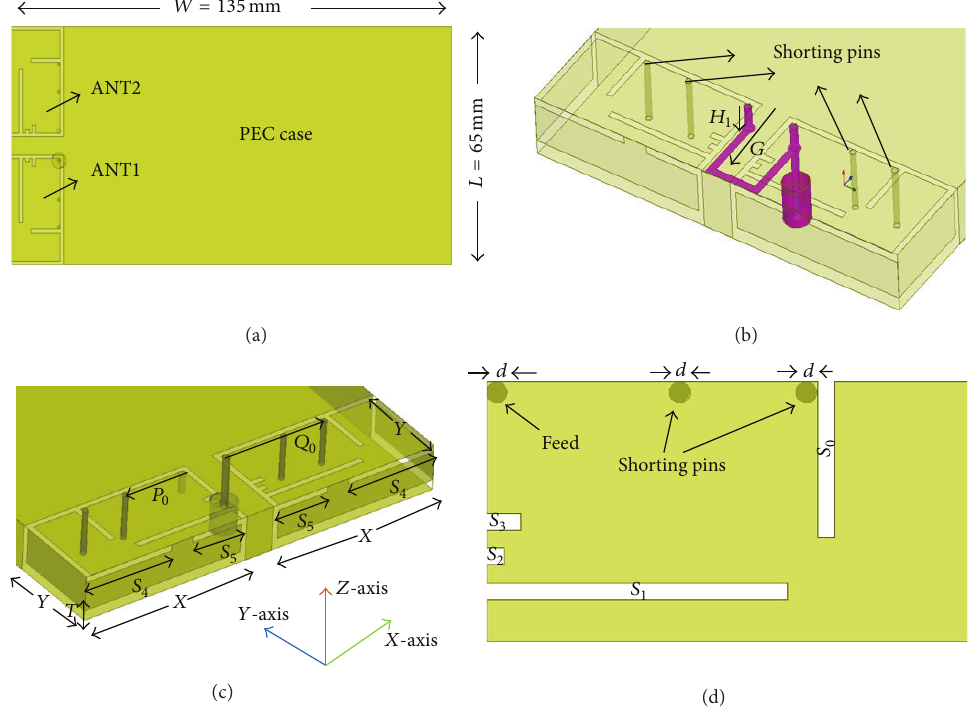
Figure 1: Proposed antenna design: (a) top view of the model, ANT1, ANT2, and PEC case, (b) feeding scheme, (c) antennas with parametric labels, and (d) antenna slot